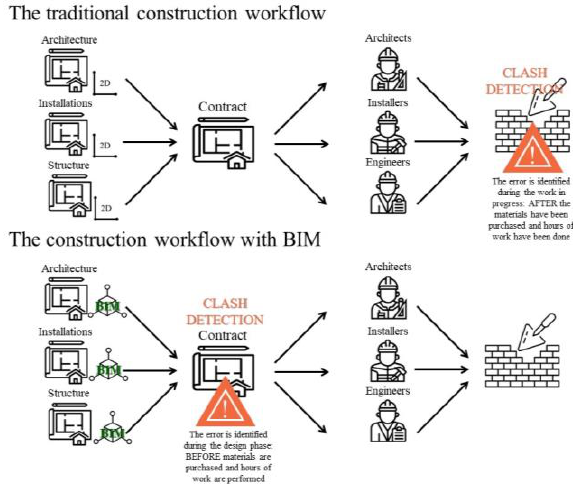
Figure 3. Comparison between the traditional construction workflow and the BIM one 3. Have a “dynamic” documentation, constantly updated;